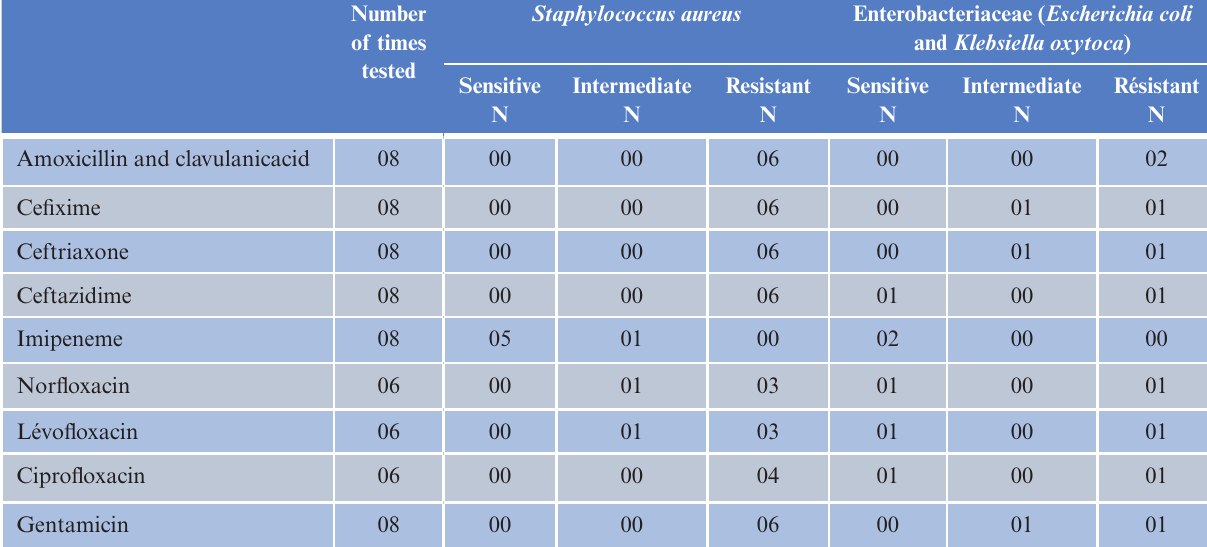
Table 2: Distribution of germs isolated from newborns at the Departmental Teaching Hospital of Borgou-Alibori (DTH-B/A) in 2019 presenting urinary tract infection according to their sensitivity to antibiotics.